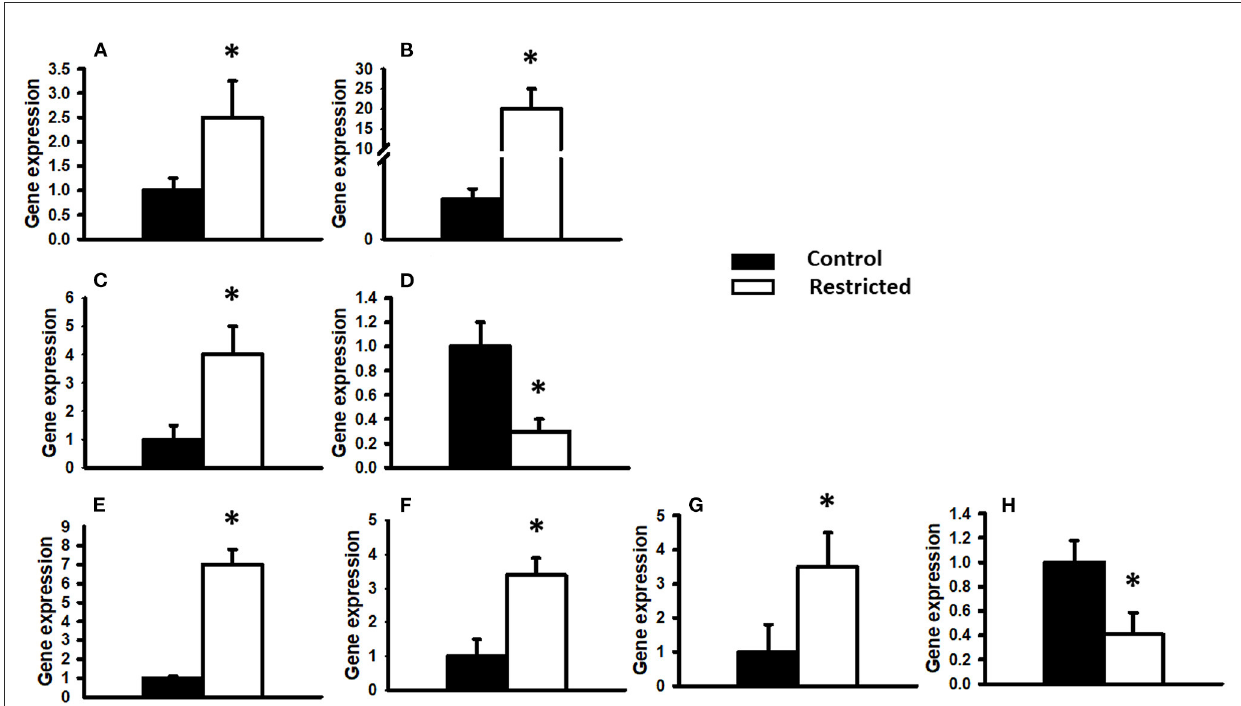
FIGURE4 Gene expression relative to the constitutive gene β -actin. The expression of different genes in PND 36 male offspring from control and restricted mothers is shown. (A) Insulin 1, (B) Insulin 2, (C) Glucose transporter 2 ( Glut2 ), (D) Glucokinase ( Gck ), (E) Pancreatic and duodenal homeobox 1 ( Pdx1 ), (F) Musculoaponeurotic fibrosarcoma oncogene family A ( MafA ), (G) Activating transcription factor 2 ( Atf2 ), (H) NeuroD1 . Data are expressed as the mean ± SEM of three independent experiments conducted in duplicate. * P < 0.05 compared with control.